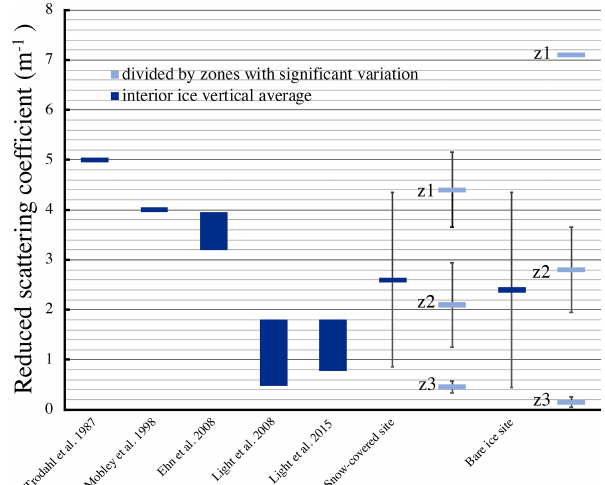
Figure 10. Comparison of the vertical averages of b measured in situ at both sampling sites to vertical averages of b published over the past for polar interior sea ice using various methods. For our measurements, the average reduced scattering coefficient b is also divided by zones. Zones are separated at depths where we observed significant changes in scattering properties. The error bars represent the standard deviation for the given depth